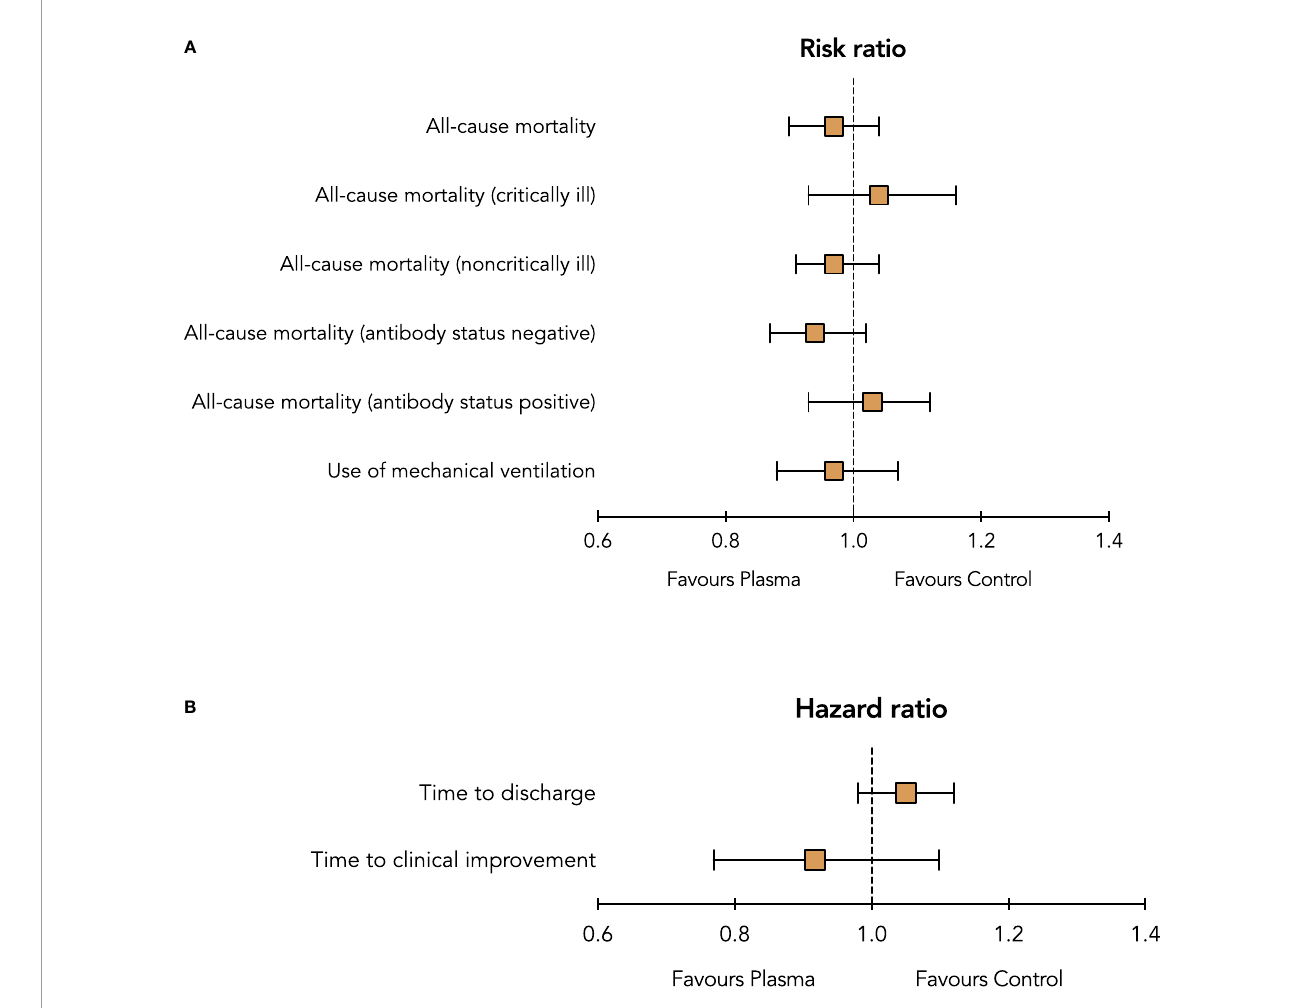
FIGURE 3 | Summary risk ratios (A) and hazard ratios (B) of outcomes between treatment with convalescent plasma and control (standard of care with or without